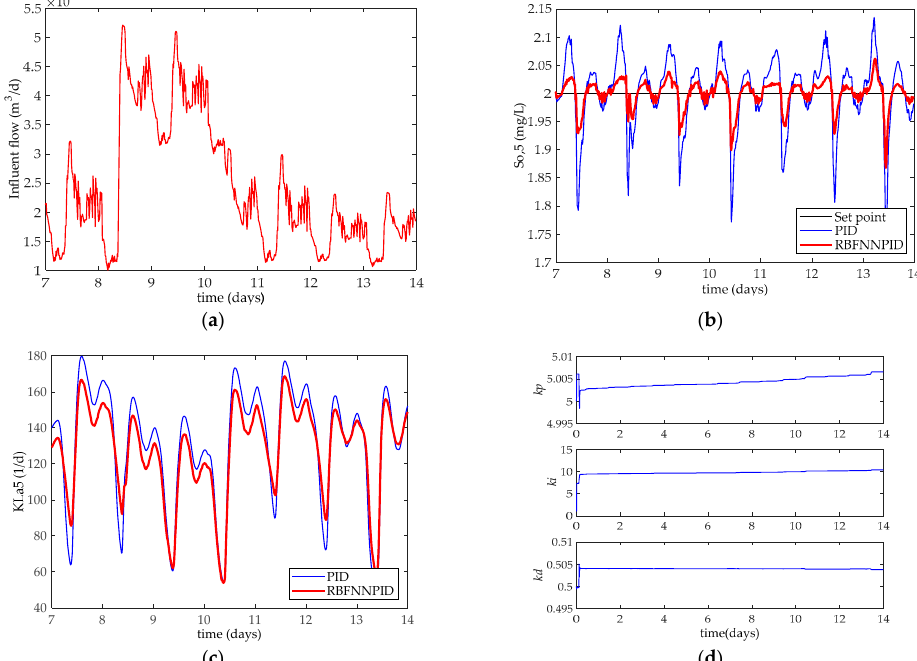
Figure 8. Comparison results of the anti-disturbance performance (rain weather): ( a ) Influent flow rate (days 7 to 14); ( b ) DO concentration in the fifth tank; ( c ) Dynamic changes of the manipulated variable K L a 5 ; ( d ) Dynamic adaptive adjustments of the three parameters kp , ki , kd of RBFNNPID algorithm.